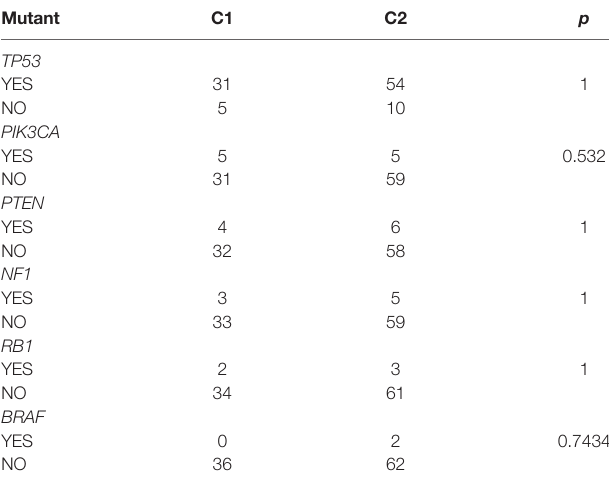
TABLE 3 | Signature gene distribution in a subset of the TCGA-TNBC cohort. Mutant C1